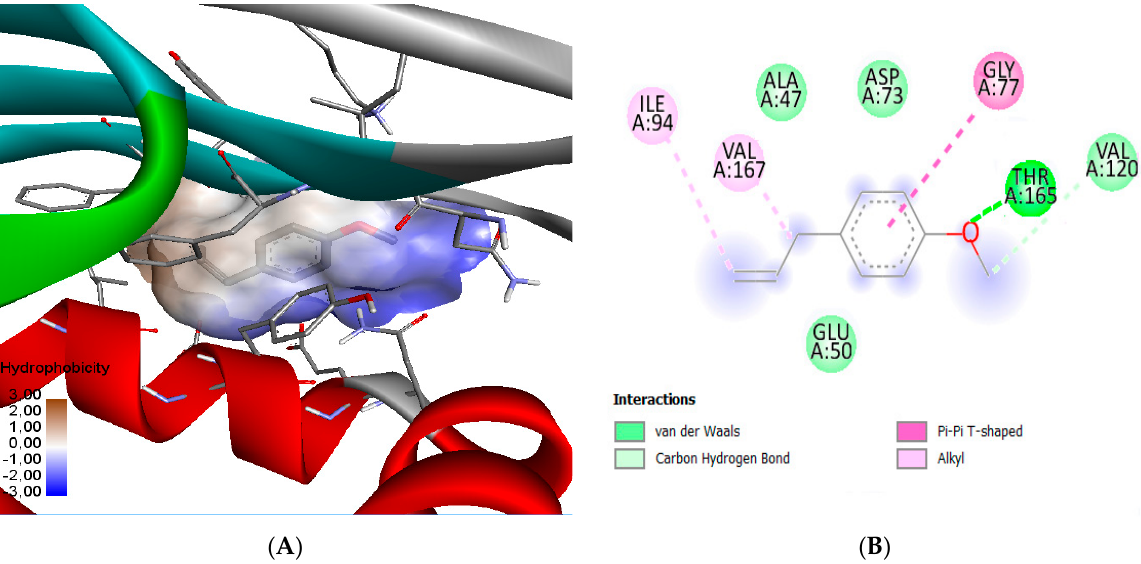
Figure 3. 2D diagram ( A ) and 3D representation ( B ) of the docking pose of the inhibitor methyl chavicol in the active site of E. coli DNA gyrase B (PDB ID: 4DUH) with an RMSD of 0.575 Å.